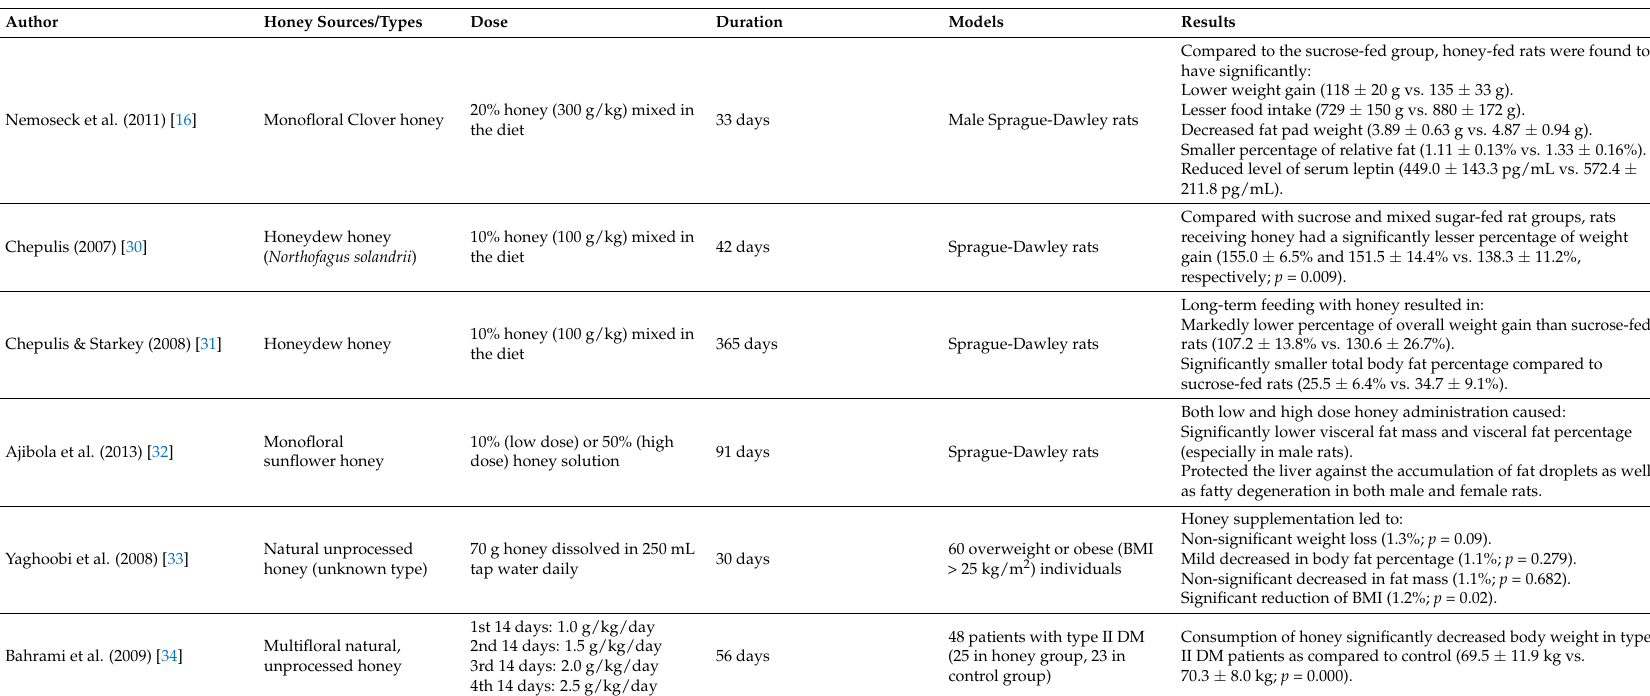
Table 1. Anti-obesity effects of honey in clinical and pre-clinical